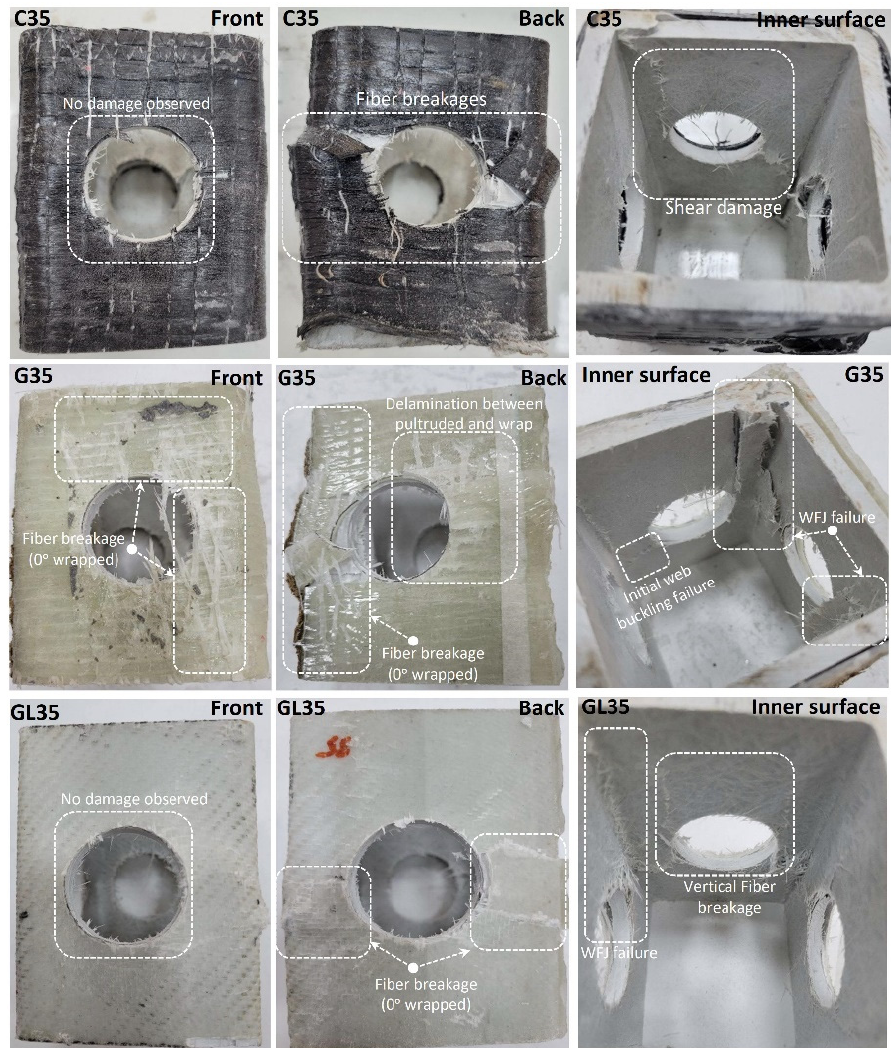
Figure 9. Damage analyses of C35, G35, and GL35.